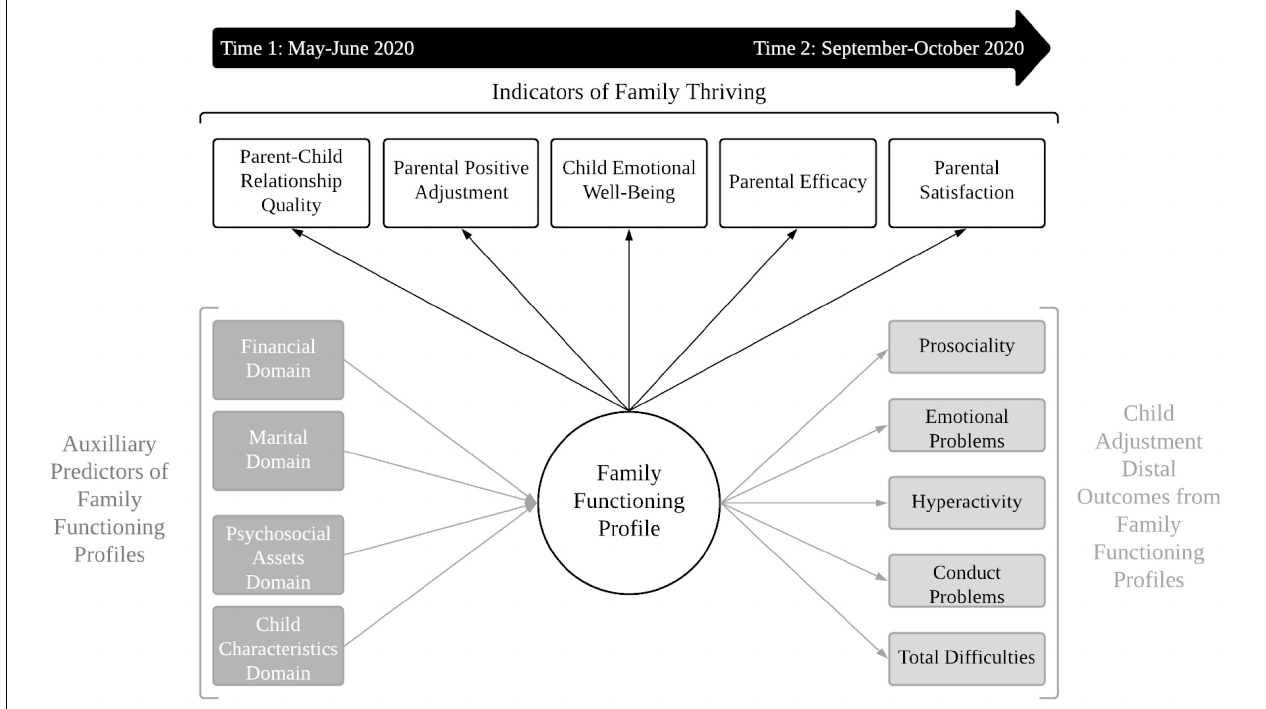
FIGURE 1 | Conceptual figure of study aims. Parent–child relationship quality, parental positive adjustment, child emotional well-being, parental efficacy, and parental satisfaction are expected to underlie multiple patterns of family functioning during the early stages of the pandemic (May–June 2020), with one pattern distinguishing a family thriving profile. Multiple factors within financial, marital, psychosocial assets, and child characteristic domains are expected to distinguish family thriving from other family functioning profiles. Finally, family functioning profiles early in the pandemic are expected to influence children’s subsequent adjustment as the pandemic continued (September–October